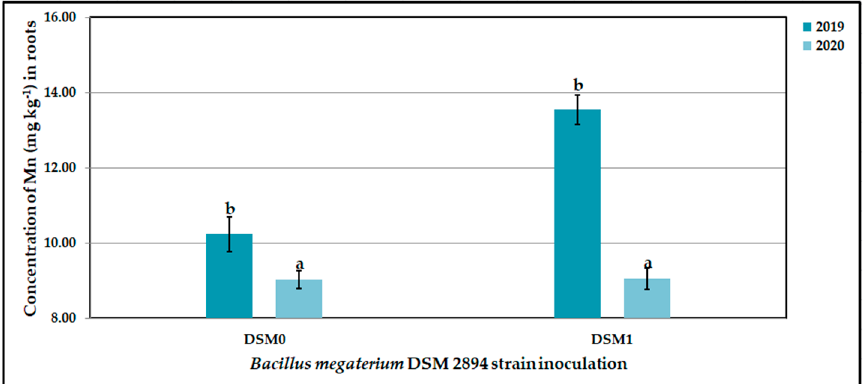
Figure 14. Influence of Bacillus megaterium DSM 2894 var. on root manganese (Mn, mg kg − 1 ) contents of CaCO 3 ‐ stressed sweet potato plants in 2019 and 2020 seasons. Bars with a different letter indicate significant difference between treatments at p ≤ 0 .05. DSM 0 = non ‐ inoculated with Bacillus megaterium DSM 2894 var., DSM 1 = inoculated with Bacillus megaterium DSM 2894 var.